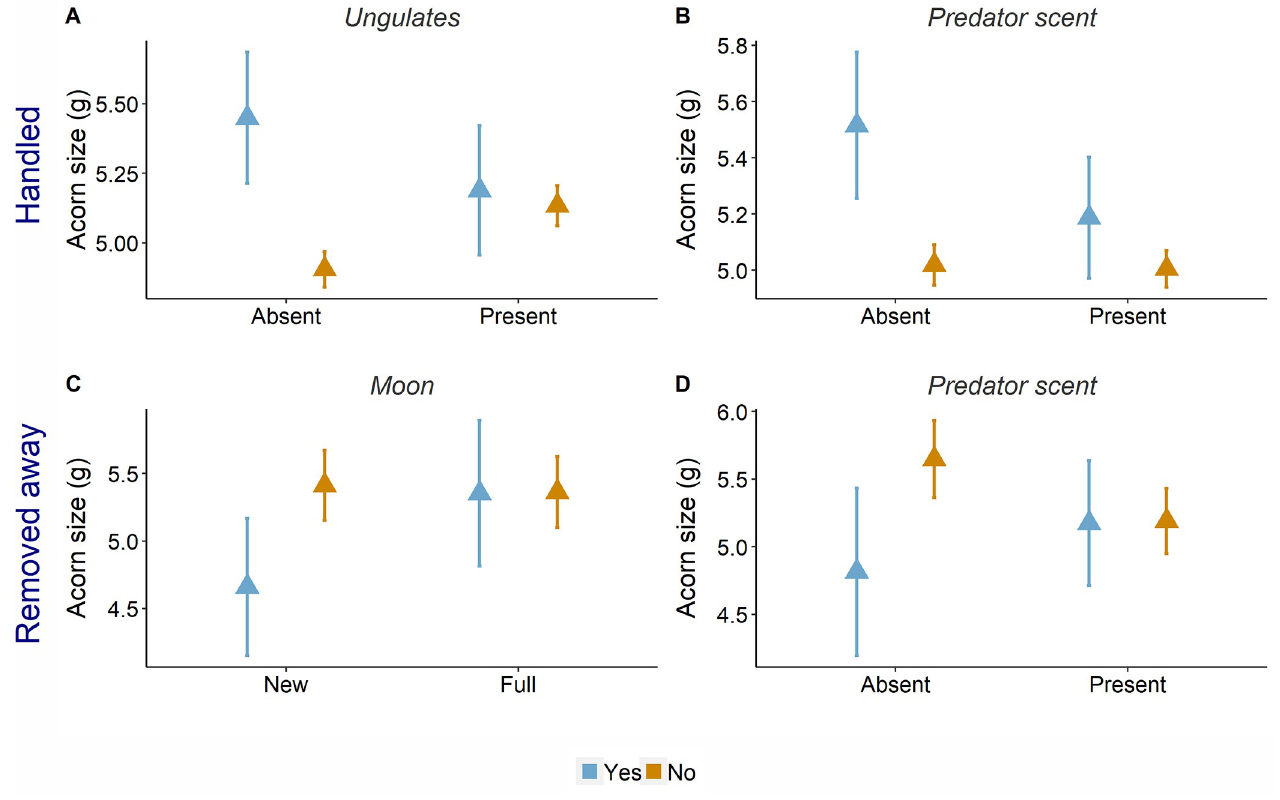
Fig 1. Mouse foraging decisions during acorn selection and removal (upper and lower panels, respectively). Size of handled acorns in the presence or absence of (A) ungulates and (B) predator scent. Size of acorns (removed away from the cage or not) (C) under new or full moon conditions and (D) in the presence or absence of predator scent. Point colors depict whether the acorn was selected or removed (yes, blue) or not (no, orange). In all cases acorn size is expressed in grams. Points represent mean values, bars standard errors (N = 1677 foraging events).